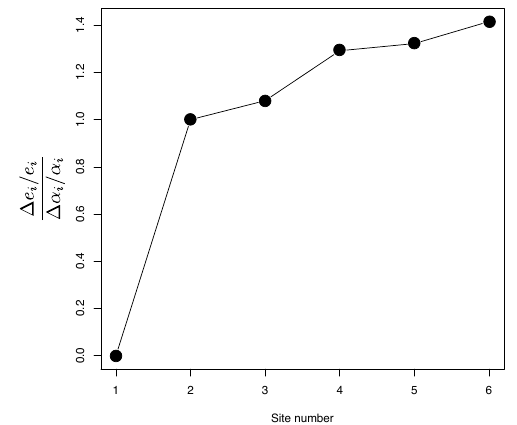
Figure 10. Relative uncertainty in erosion rate scaled by the rel- ative uncertainty in mineral concentration factor for the estimates obtained at each of the six sites along the main river trunk. The first site has a fixed relative erosion rate ( = 1) and therefore no uncer-